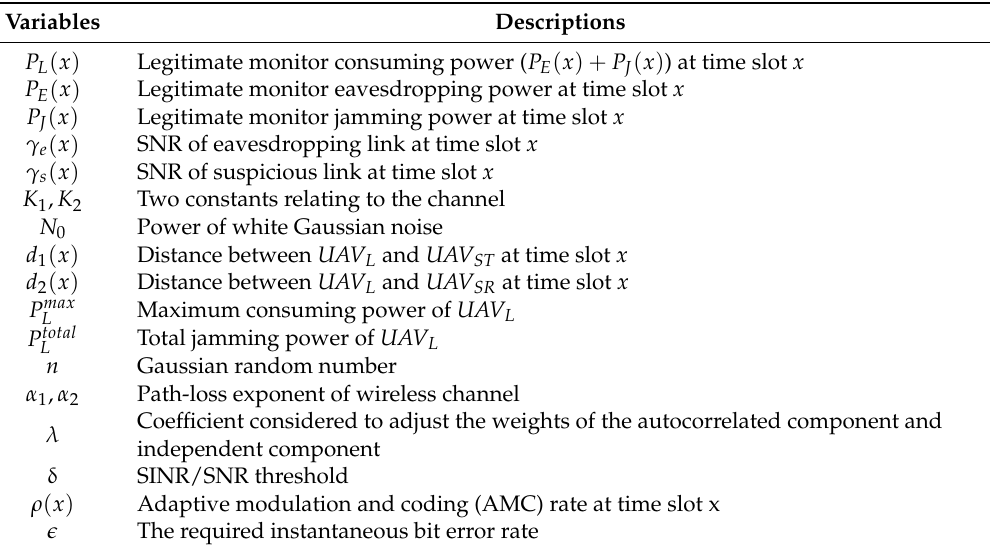
Table 1. Notations and